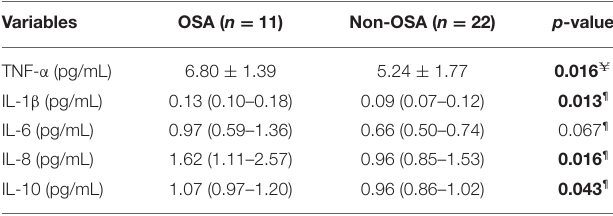
TABLE 3 | Inflammatory profiles in pregnant women with and without